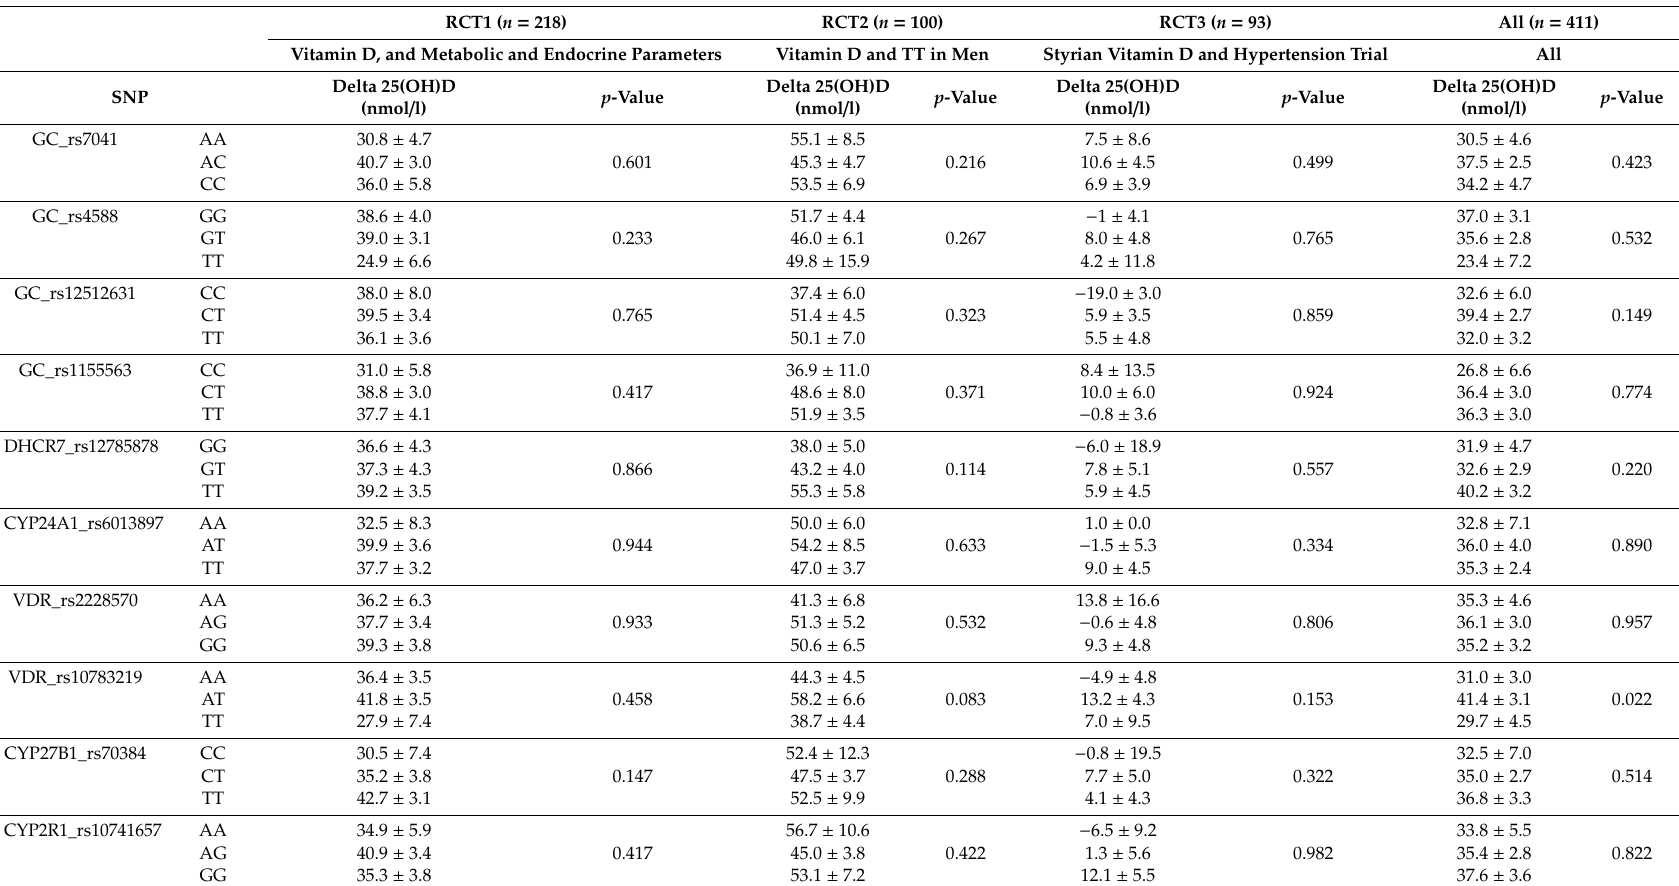
Table 3. Delta 25(OH)D values according to selected SNP